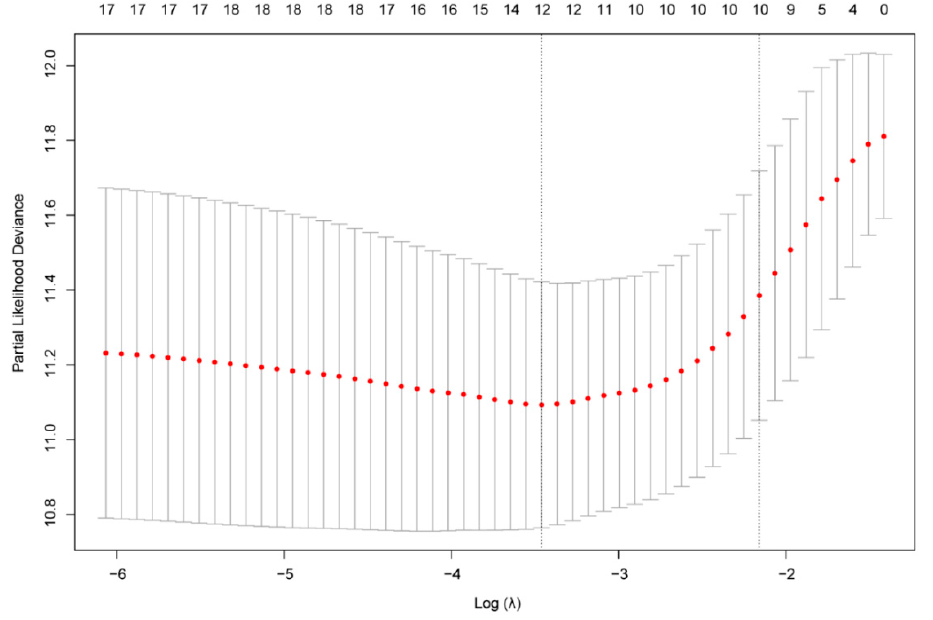
Figure 2. Lasso regression analysis of IL-4-associated genes with high prognostic values (Uni-Cox p < 0.05) generated 10 genes as covariates to calculate the gene risk signature. Dotted line indicated the most preferred λ value as the L1-regularization of Lasso regression. Box lines represented the variances of partial likelihood deviance of the λ value. Table 1. Univariate Cox regression analysis and LASSO regression coefficients of 10 genes gener- ated by LASSO regression analysis.